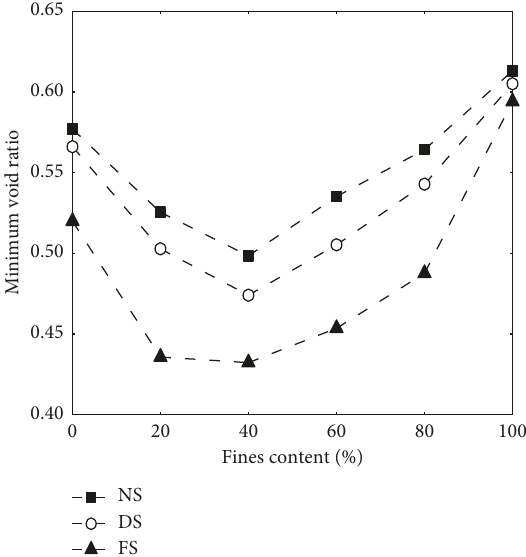
Figure 7: Mixing two groups (1-2 mm and